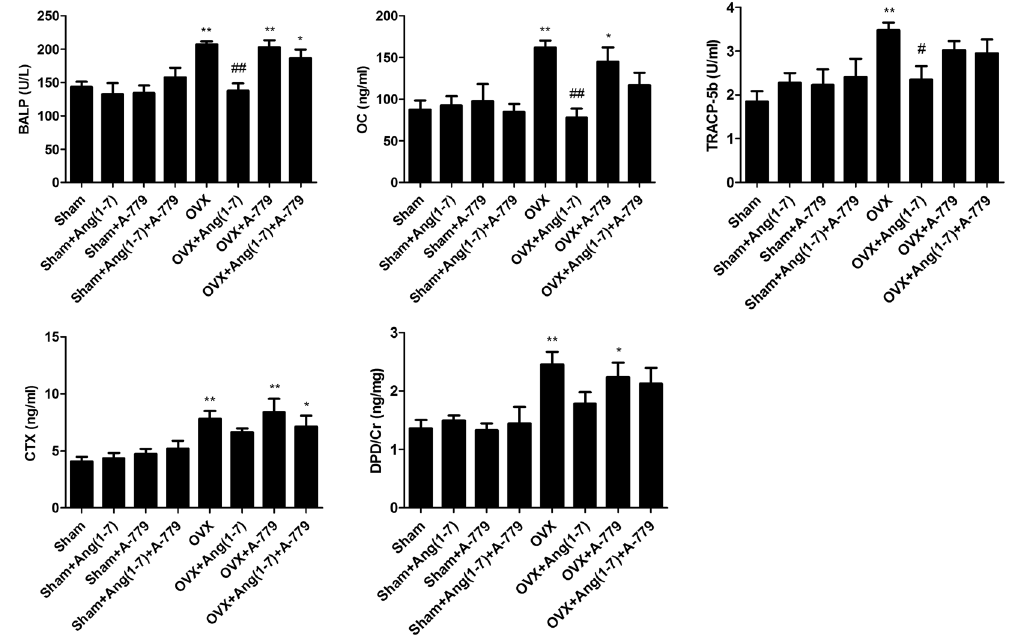
Figure 2. Effects of Ang(1-7) and/or A-779 treatments to sham and OVX animals for 6 weeks on bone turn over biomarkers in Wistar albino rats. Levels of BALP, OC, TRACP-5b and CTX were quantified in serum, while the urinary levels of DPD was estimated using sandwich ELISA technique. One-way ANOVA test followed by post hoc Student-Newman-Keuls multiple comparisons test were used for the statistical analysis. Columns and bars represent the mean ± SEM of each group (n = 8/group). Statistical significance was considered when * P < 0.05 and ** P < 0.01 as compared to Sham group and # P < 0.05 and ## P < 0.01 as compared to OVX